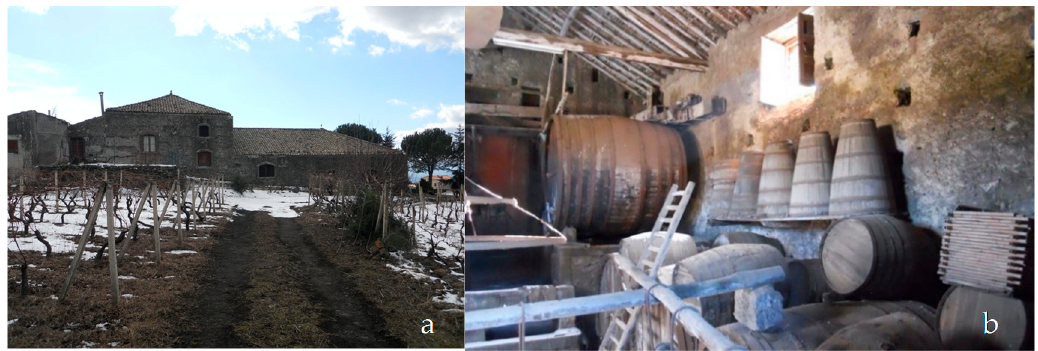
Figure 1. ( a ) The north façade of the wine cellar; ( b ) internal room of the wine cellar.